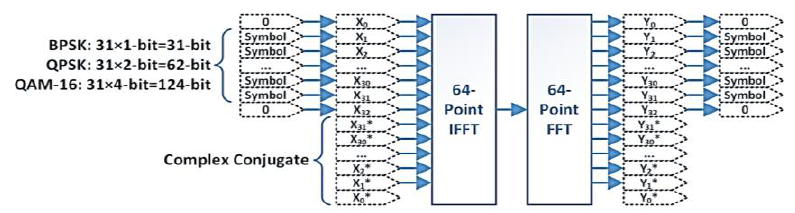
Fig. 3. FFT and IFFT